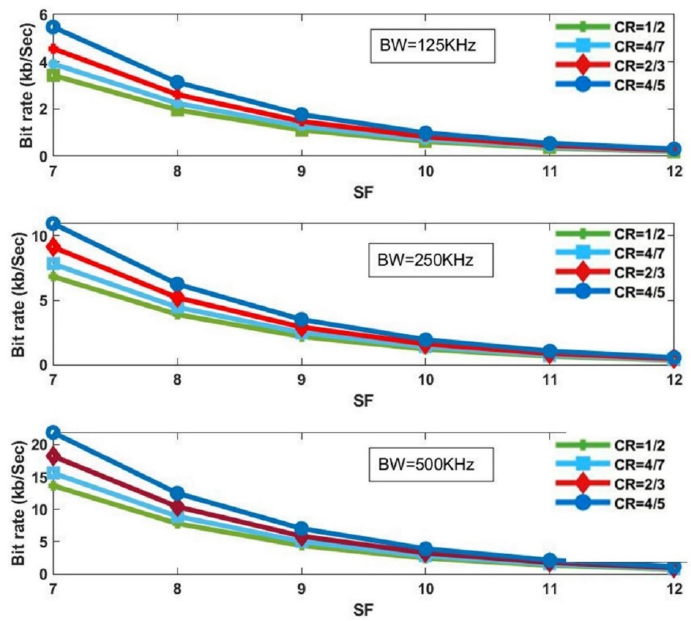
Figure 21. Bit rate of LoRa-based network versus SF computed at different values of BW and CR .